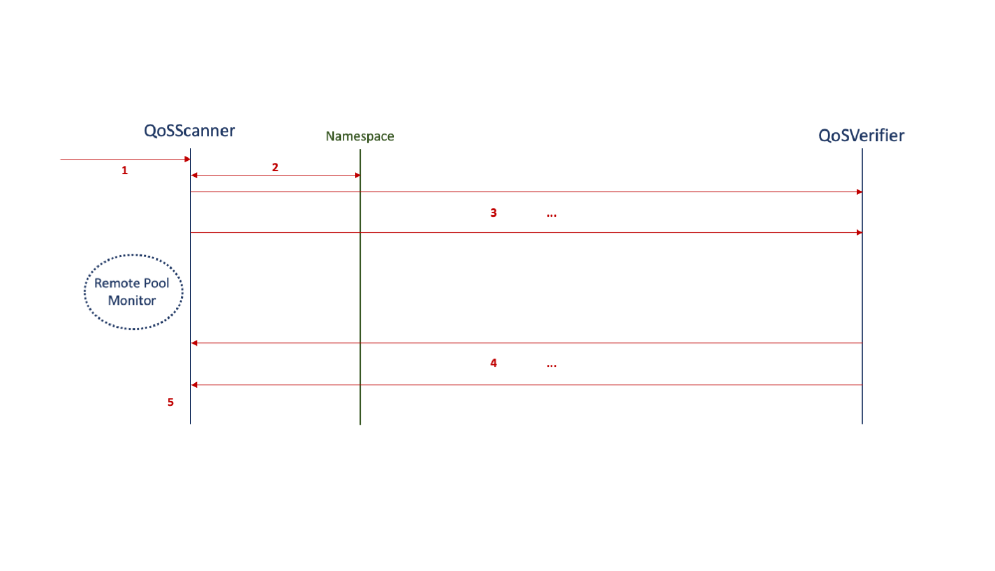
Figure 5. QoS Request Handling. A - the current rule engine uses the namespace and Pool Selection Unit. B - The pool selection is done by the verifier and sent as part of the message to the adjuster; verifier keeps track of maximum running slots and only sends ready tasks to the adjuster. C - The adjuster queues the requests, maps them to adjuster types and executes; the types call out to either the pools or the PinManager.